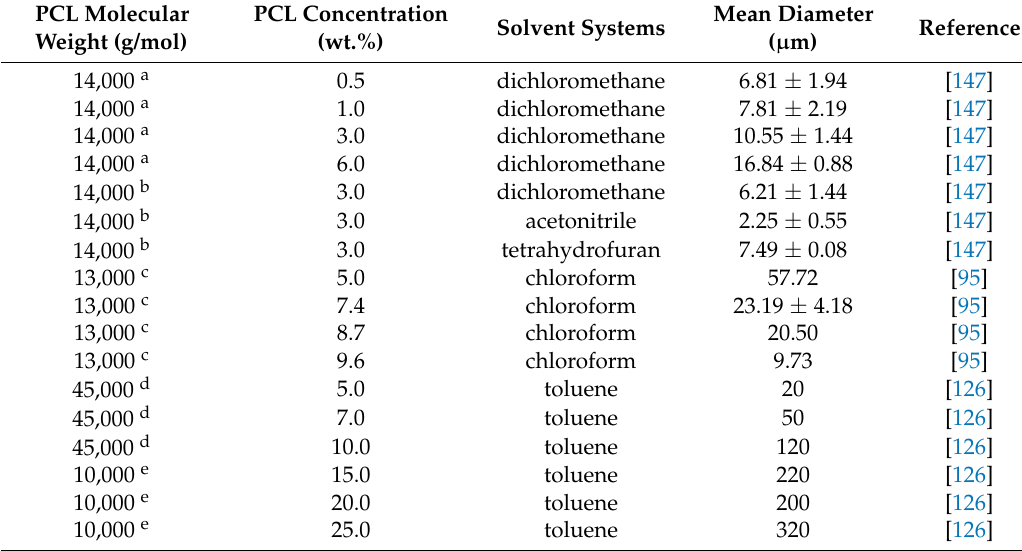
Table 4. Mean diameter of electrosprayed PCL microparticles obtained from different PCL concentration, molecular weight, and solvent